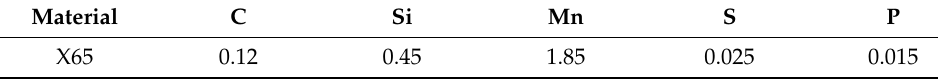
Table 1. Chemical compositions (in wt%) of X65.